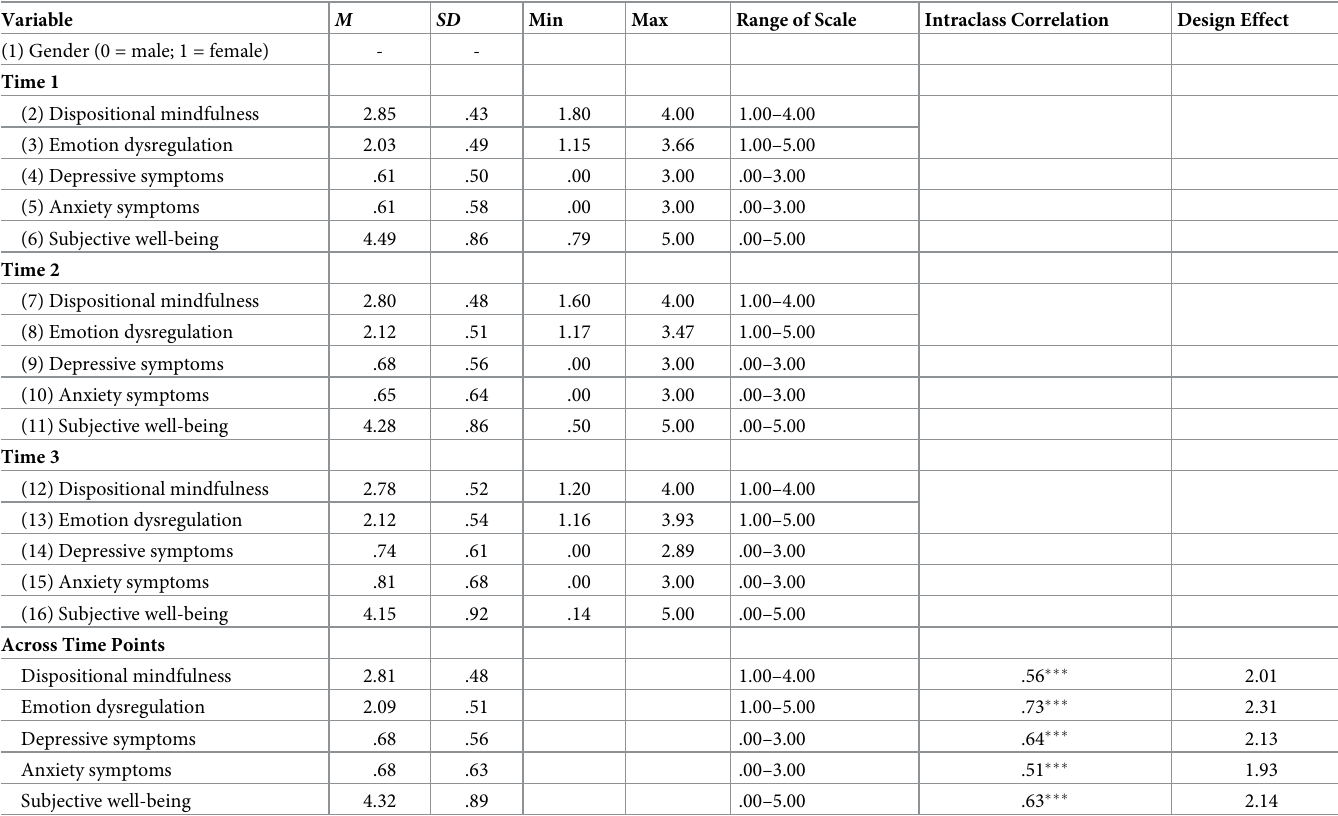
Table 1. Descriptive statistics of the variables under study ( N =